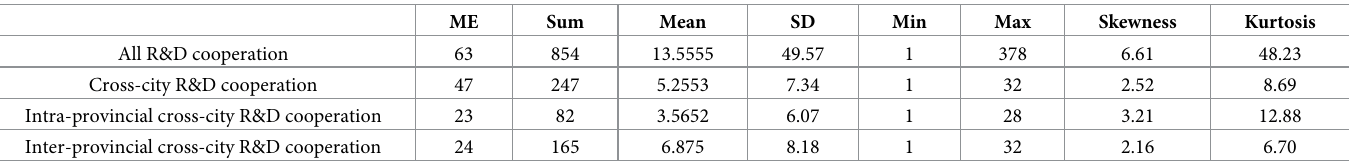
Table 2. Descriptive statistics of the Yangtze River Delta